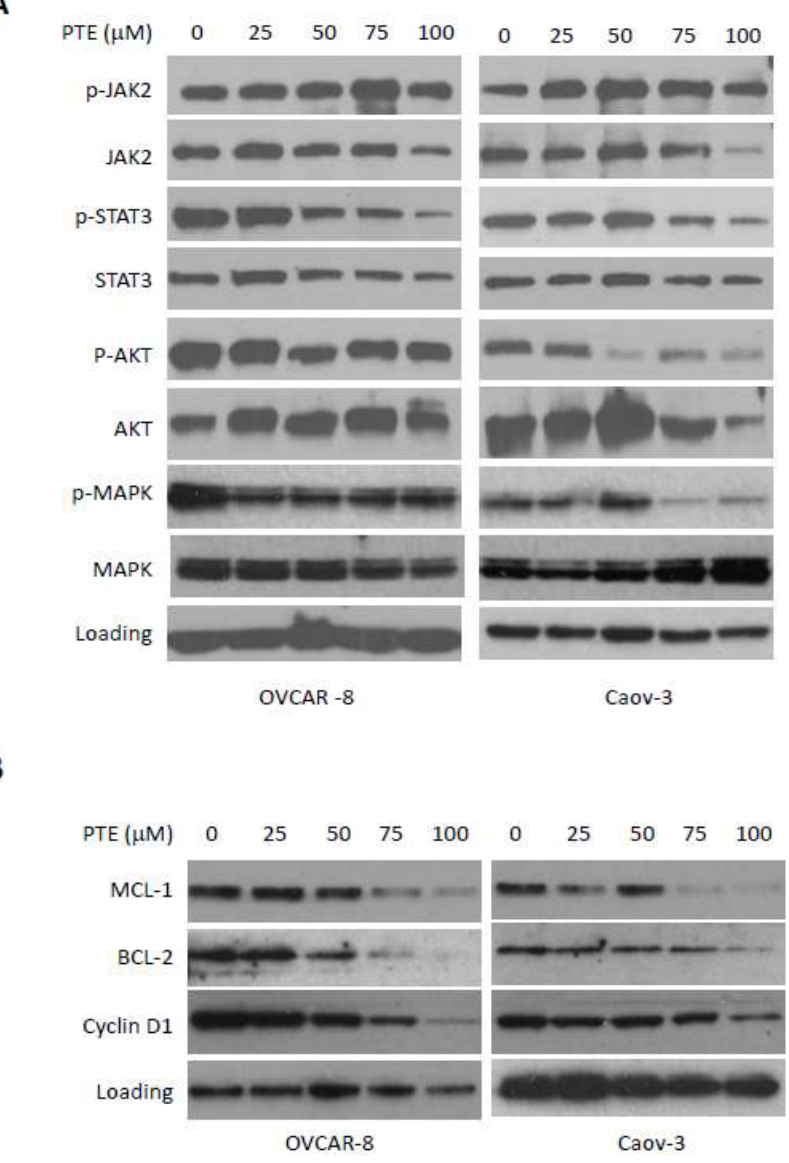
Figure 5. Pterostilbene inhibits STAT3 activation. OVCAR-8 and Caov-3 cells were treated with PTE at various concentrations for 24 h. Cells were harvested and analyzed ( A ) for the phosphorylation of STAT3, AKT and ERK and ( B ) for the expression of STAT3 downstream molecules, MCL-1, BCL-2 and cyclin D1. Results are representative of 3 or more preparations. cyclin D1. Results are representative of 3 or more